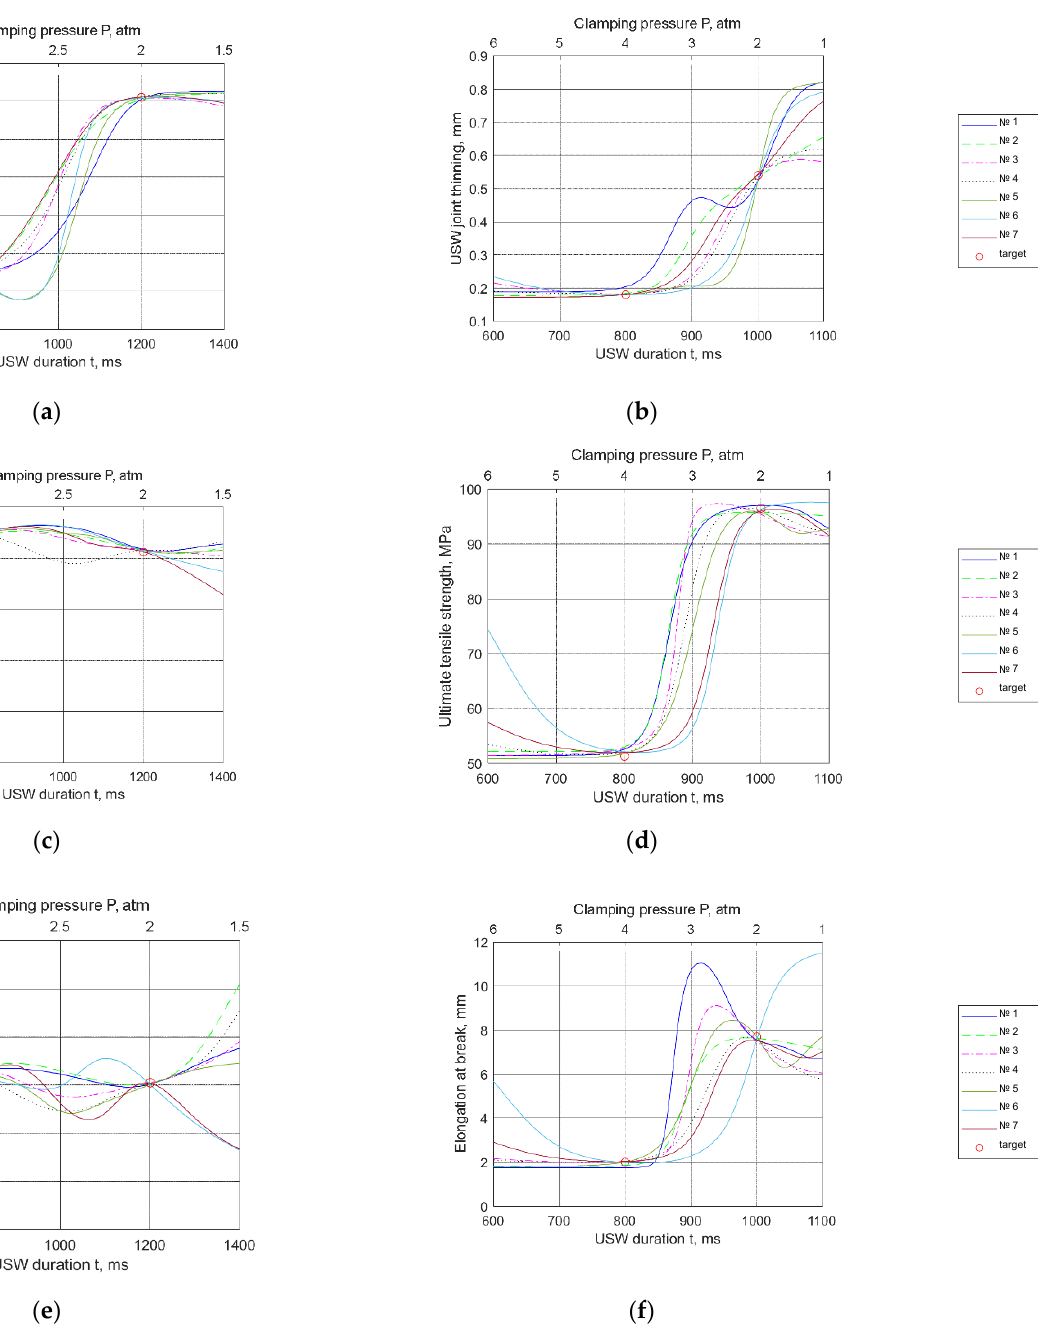
Figure 5. Simulation results over the space cross section of the USW parameters: (a, c, e) τ = 1000 ms; P = (3 − ( t − 800)/400) atm; (b, d, f) τ = 1500 ms; P = (4 − 2( t − 800)/200) atm.